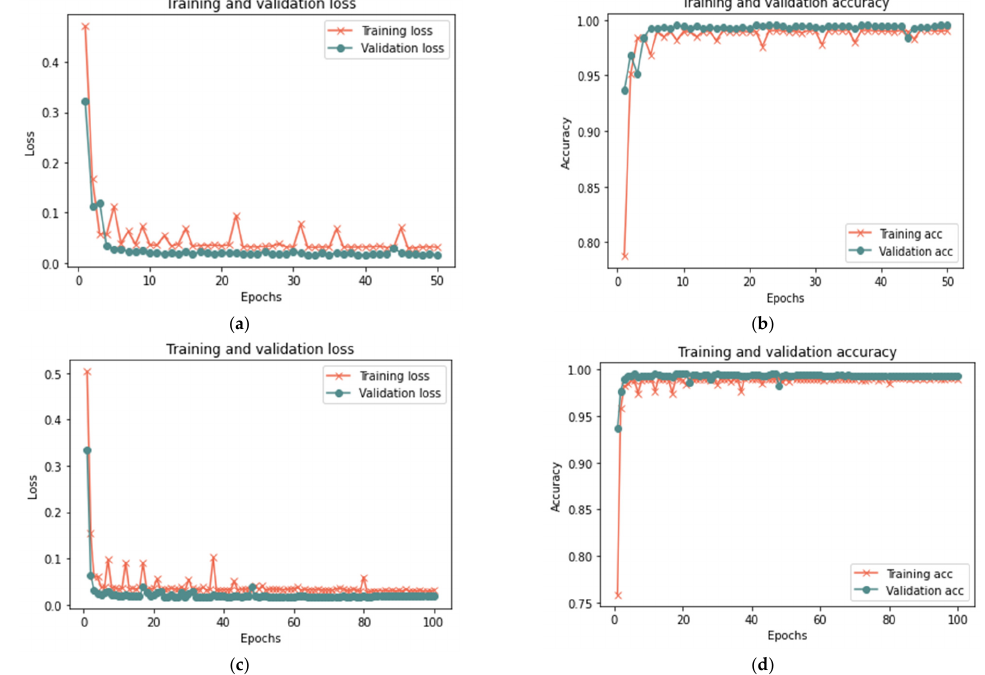
Figure 15. Results of the second scenario with 100% sample size: ( a ) loss at 50 iterations; ( b ) accuracy at 50 iterations; ( c ) loss at 100 iterations; and ( d ) accuracy at 100 iterations.